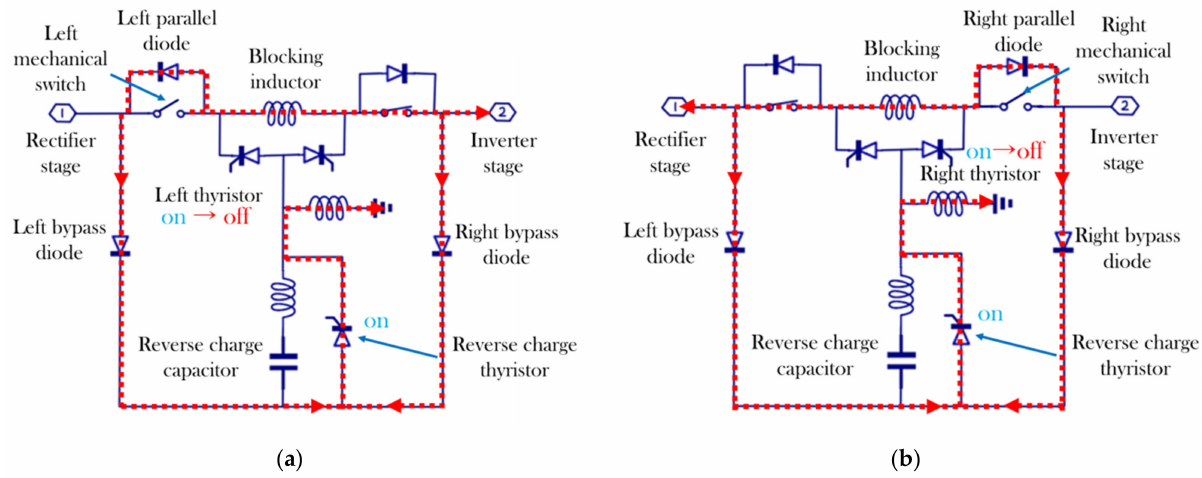
Figure 3. Flow of residual current after zero-crossing of the main switch of the proposed DCCB: ( a ) Current flow after breaking the fault current passing from the rectifier stage to the DCCB; ( b ) Current flow after breaking the fault current passing from the inverter stage to the